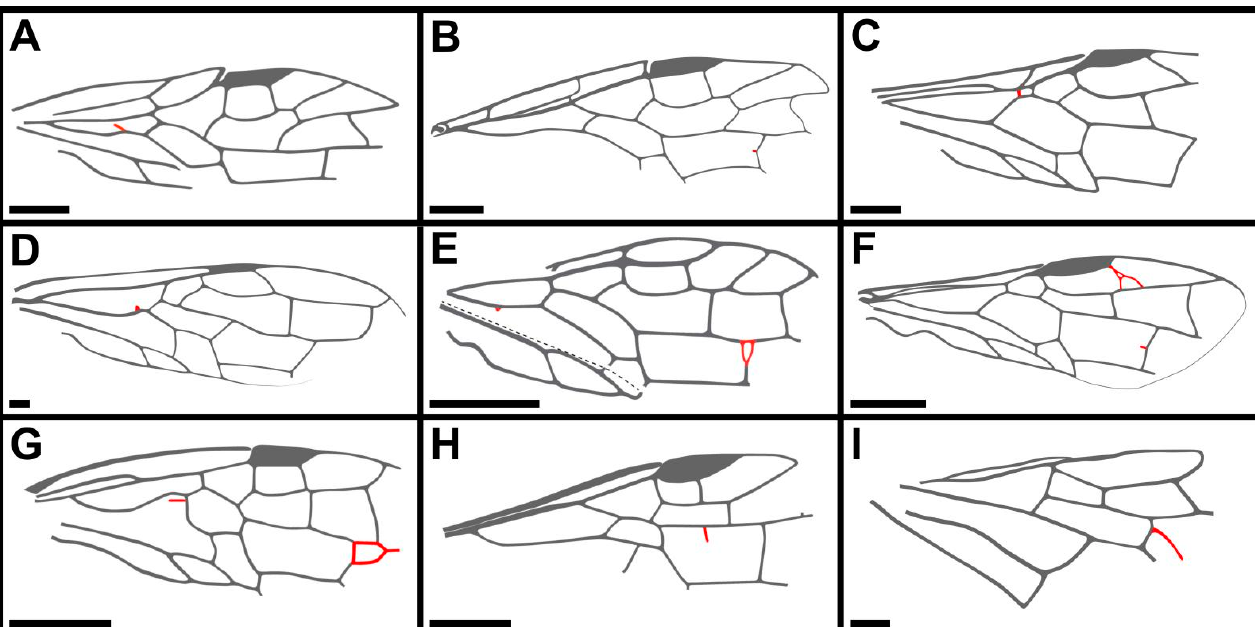
Figure 6. Several examples of wing venation variation in fossil Symphyta. ( A ), Chionoxyela nivea Rasnitsyn, 1993 (Xyelidae) ([34], Figure 12). ( B ), Shartexyela mongolica Rasnitsyn, 2008 (Xyelidae) ([35], Figure 1B). ( C ), Xyelocerus diaphanous Gao, Ren and Shih, 2009 (Xyelotomidae) ([36], Figure 2B). ( D ), Hoplitolyda duolunica Gao, Shih, Rasnitsyn and Ren, 2013 (Praesiricidae) ([37], Figure 3B). ( E ), Potrerilloxyela menendez Lara, Rasnitsyn and Zavattieri, 2014 (Xyelidae) ([38], Figure 4C). ( F ), Aethotoma aninomorpha Gao, Shih, Engel and Ren, 2016 (Xyelotomidae) ([39], Figure 2D). ( G ), Pamparaphilius khasurtensis Kopylov and Rasnitsyn, 2017 (Sepulcidae) ([40], Figure 1). ( H ), Trematothorax extravenosus Kopylov and Rasnitsyn, 2017 (Sepulcidae) ([41], Figure 5). ( I ), Brachyoxyela conjunctiva Dai, Shih and Rasnitsyn, 2022 (Xyelidae) ([42], Figure 3C). Scale bars: 2 mm in ( A – I ). Notes: specimens of Hoplitolyda duolunica , Xyelocerus diaphanous and Aethotoma aninomorpha have both wings preserved and only Hoplitolyda duolunica has symmetric venation variation. Other specimens have only a single wing preserved.